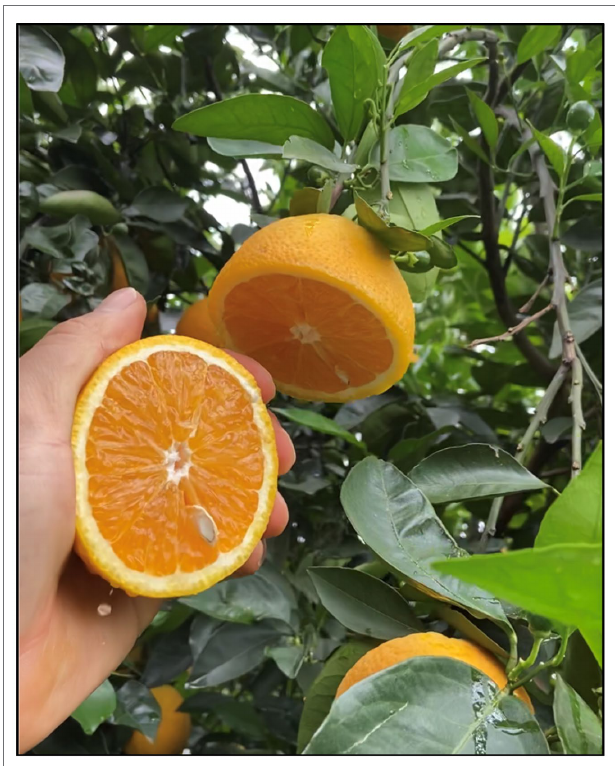
FIGURE 4 | Fruit of nine-year-old Frost Valencia sweet orange tree grafted on Rangpur lime rootstock in Guairaçá, state of Paraná, Brazil.